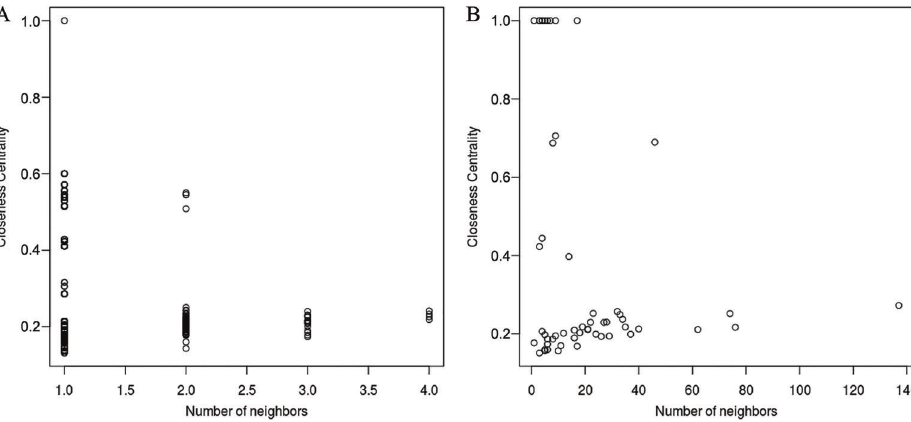
Figure 4. Comparison of closeness between lncRNAs and mRNAs in the lncRNA-mediated ceRNAs network (LMCN). A , Closeness distribution of mRNAs in the LMCN; B , Closeness distribution of lncRNAs of the LMCN.